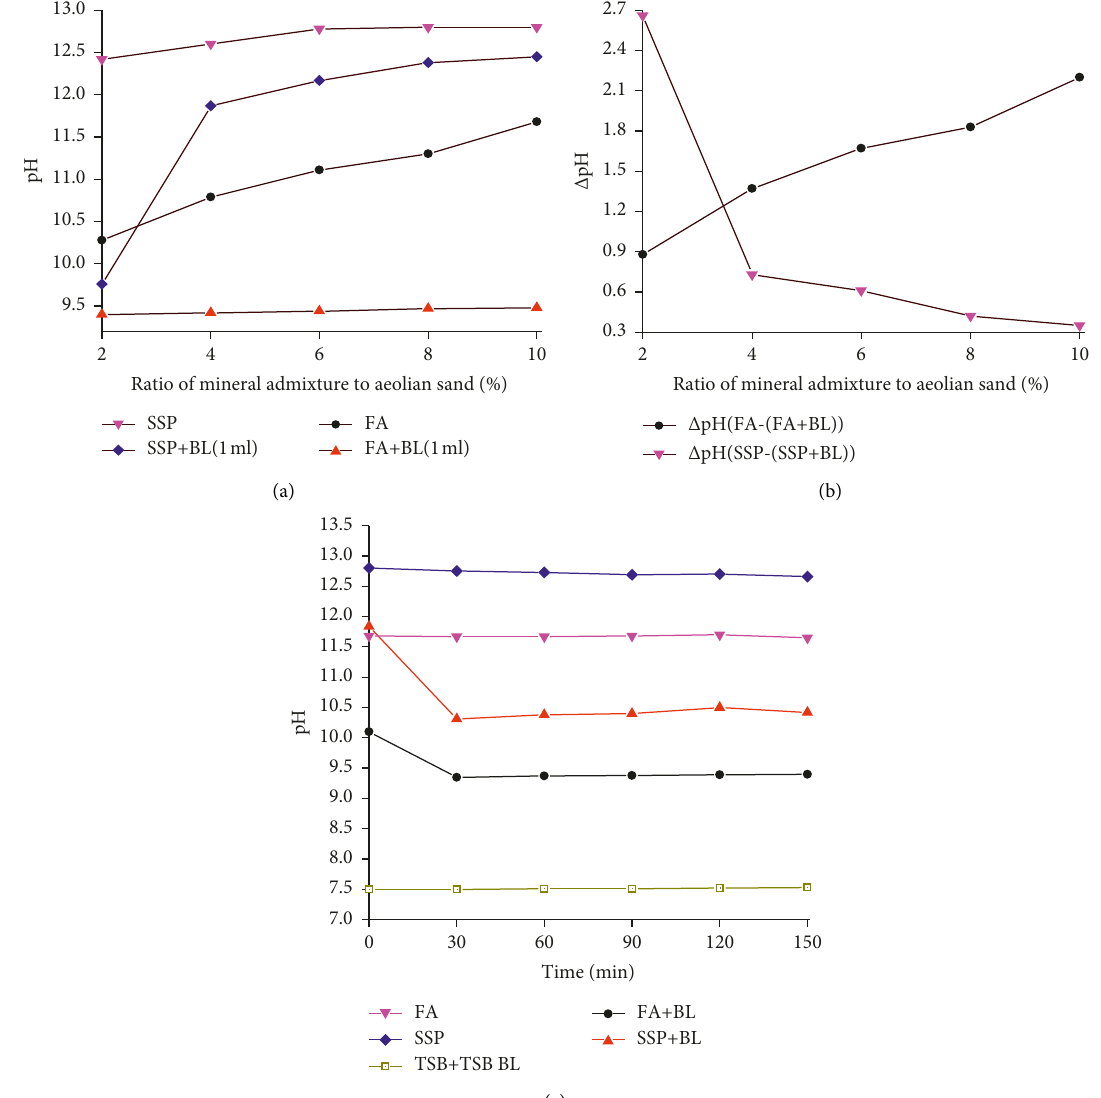
Figure 7: Effect of bacteria on the solution pH under different doping conditions: (a) effect of bacteria on the solution pH under different dosing conditions (1min), (b) change in solution pH under different dosing conditions (1 min), and (c) effect of the bacterial solution on the pH of the